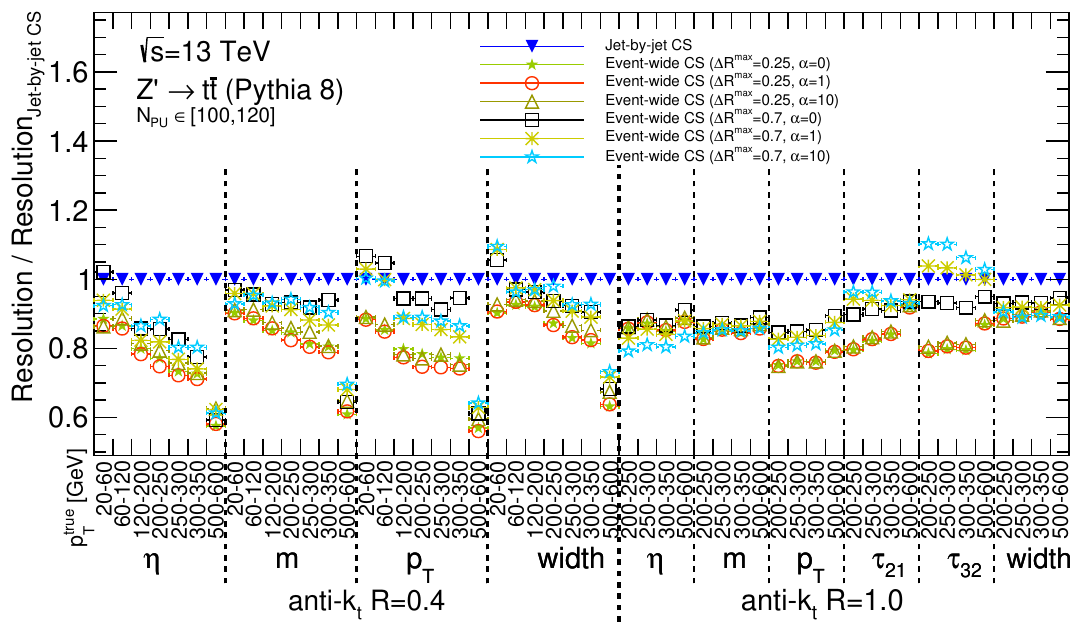
Figure 15. Dependence of resolution on the (cid:11) parameter for the Event-wide